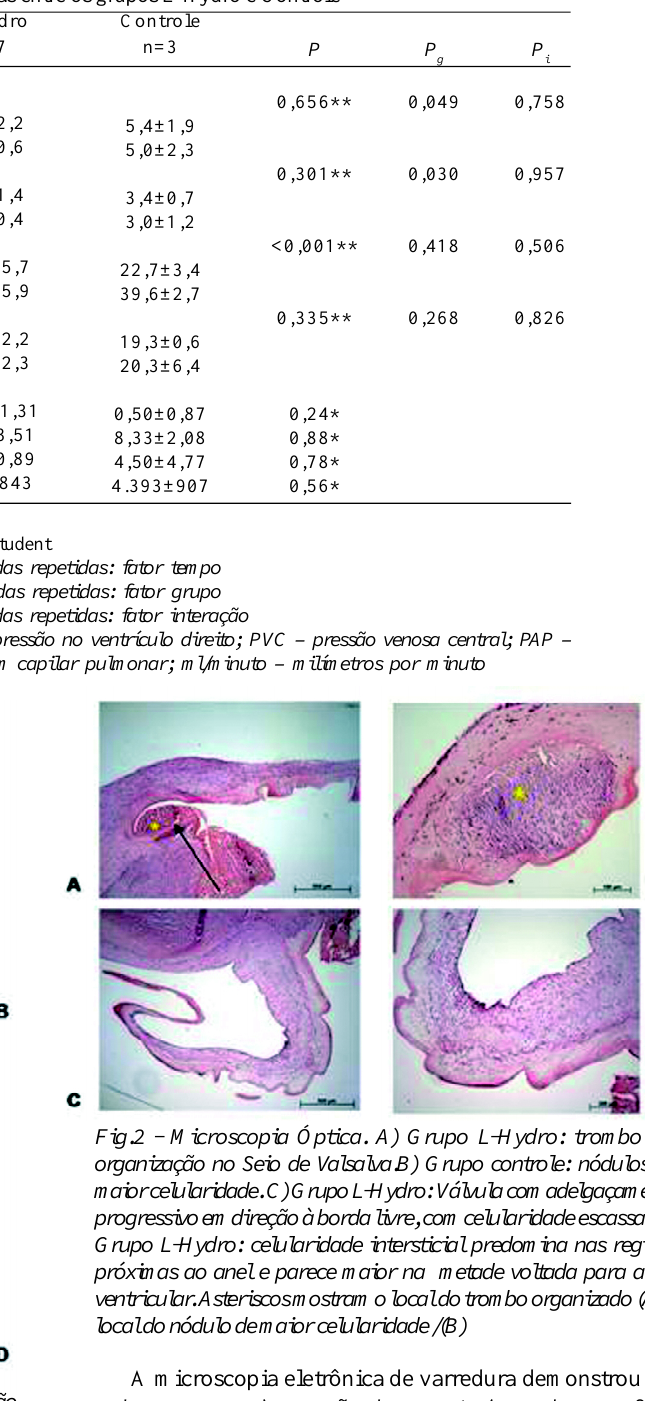
Fig. 1 - Avaliação macroscópica. A) Grupo L-Hydro: calcificação de 1 x 1mm subcomissural. Válvulas flexíveis. B) Grupo controle: trombo organizado no Seio de Valsalva de 5 x 7mm. Válvulas flexíveis. C) Grupo L-Hydro: trombo organizado na borda de livre, de 2 x 4mm. Válvulas flexíveis. D) Grupo L-Hydro: válvulas